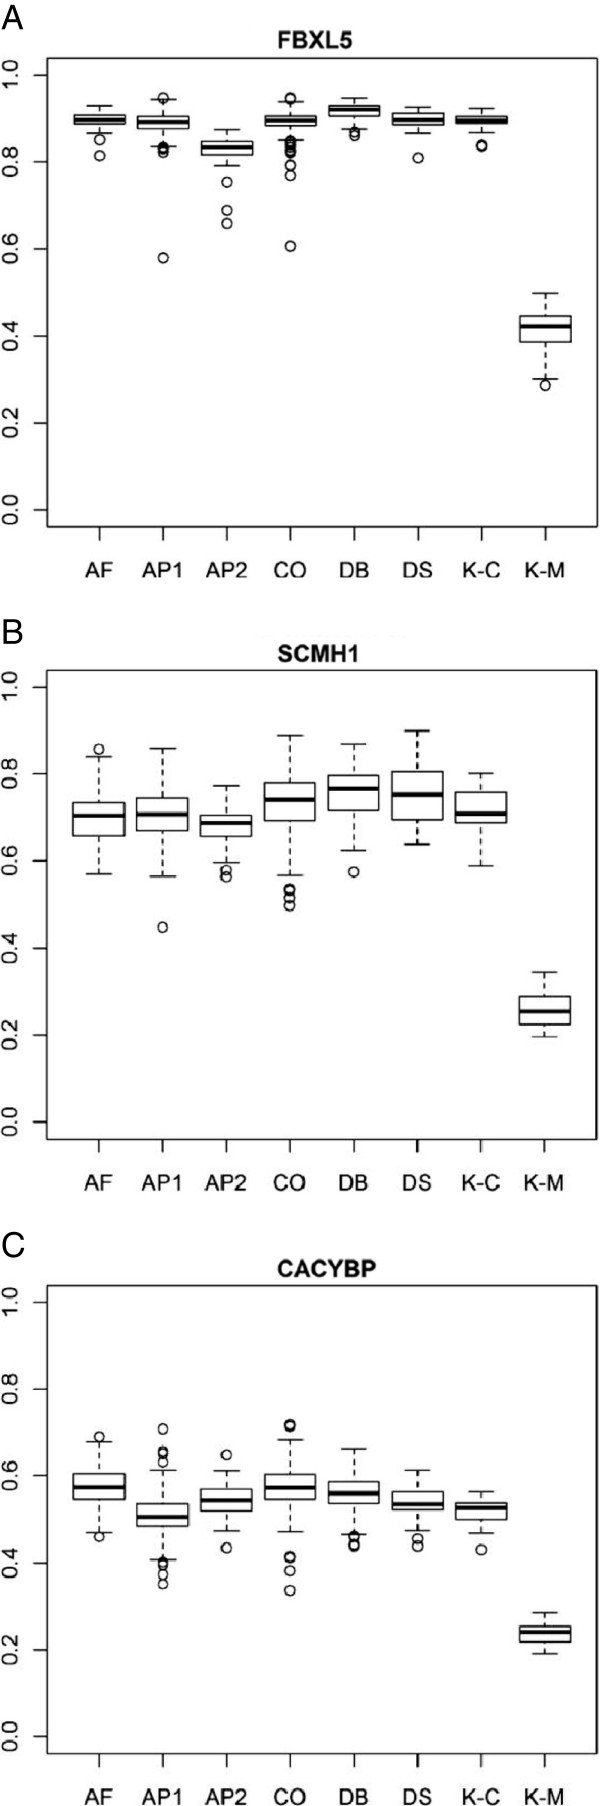
DNA methylation at the three top significant CpGs in KDM5C mutations cases and population controls. DNA methylation microarray data at three CpG sites within CpG-rich promoters of three genes FBXL5 (A), SCMH1 (B) and CACYBP (C) as determined in 6 published studies using Illumina methylation27 array. AF (Aging in females, n = 93), AP1 (aging pediatric 1, n = 398), AP2 (aging pediatric 2, n = 79), CO (cancer ovarian, n = 257), DB (diabetes, n = 99), DS (Down syndrome, n = 21), K-C are controls from our study (N = 16), K-M are KDM5C mutations cases. For CO and DS only control samples were included.